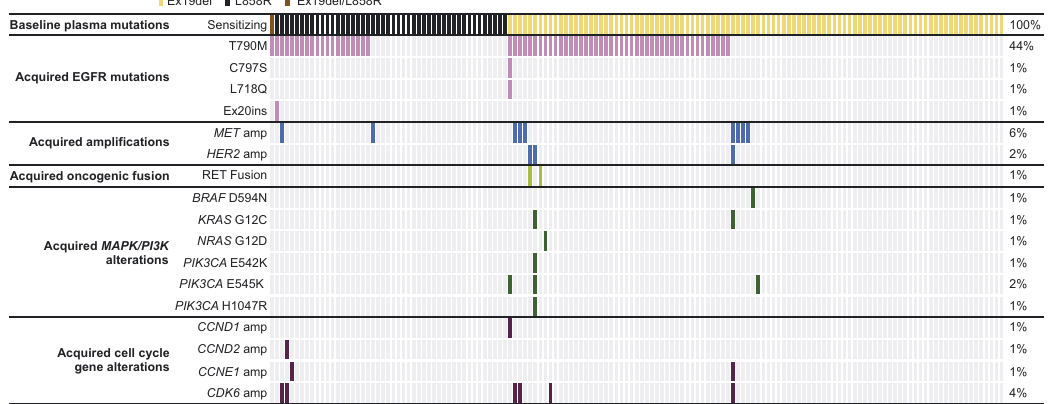
Fig. 2 | Acquired mutations following treatment with osimertinib and com- paratorEGFR-TKIs. Tileplotsindicating( A )acquiredmutationsinpatientstreated with osimertinib ( n =109) and ( B ) acquired mutations in patients treated with